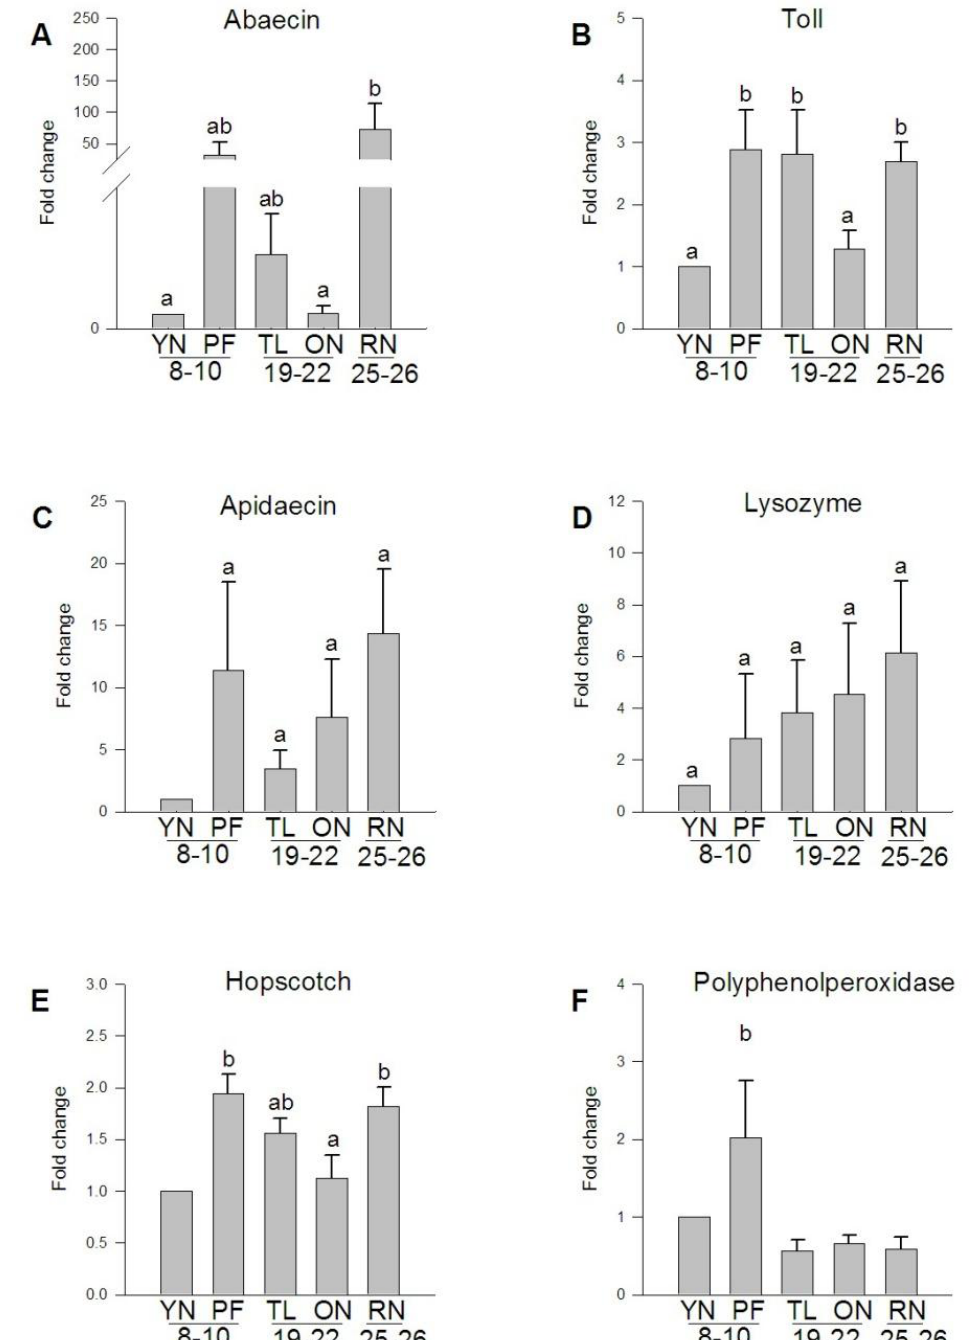
Figure 6. Expression of immune transcripts in A. mellifera flight muscle. Quantification of mRNA levels of bee specific immune transcripts ( A , C ), transcripts involved in immune signaling pathways ( B , E ), and innate immune response transcripts ( D , F ) revealed differential expression between ages and behaviors. Fold change represents the relative difference compared to one day old